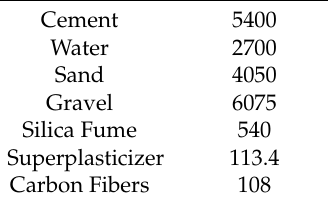
Table 2. Concrete dosage (g).